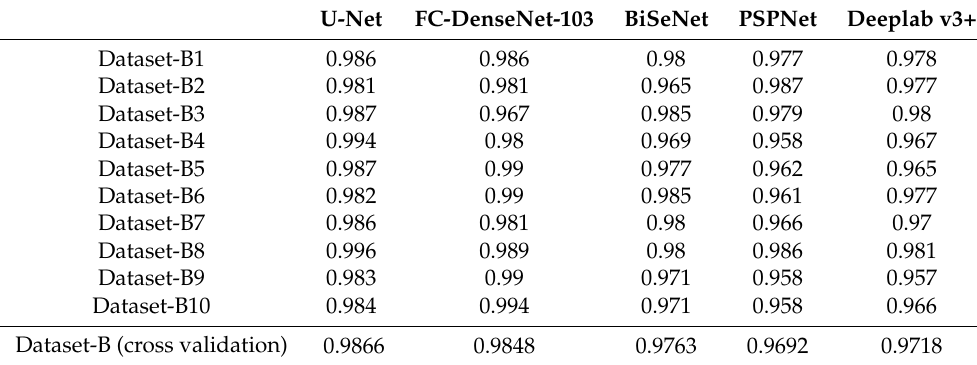
Table 10. Precision measured for every algorithm on Dataset-B (cross-validation).